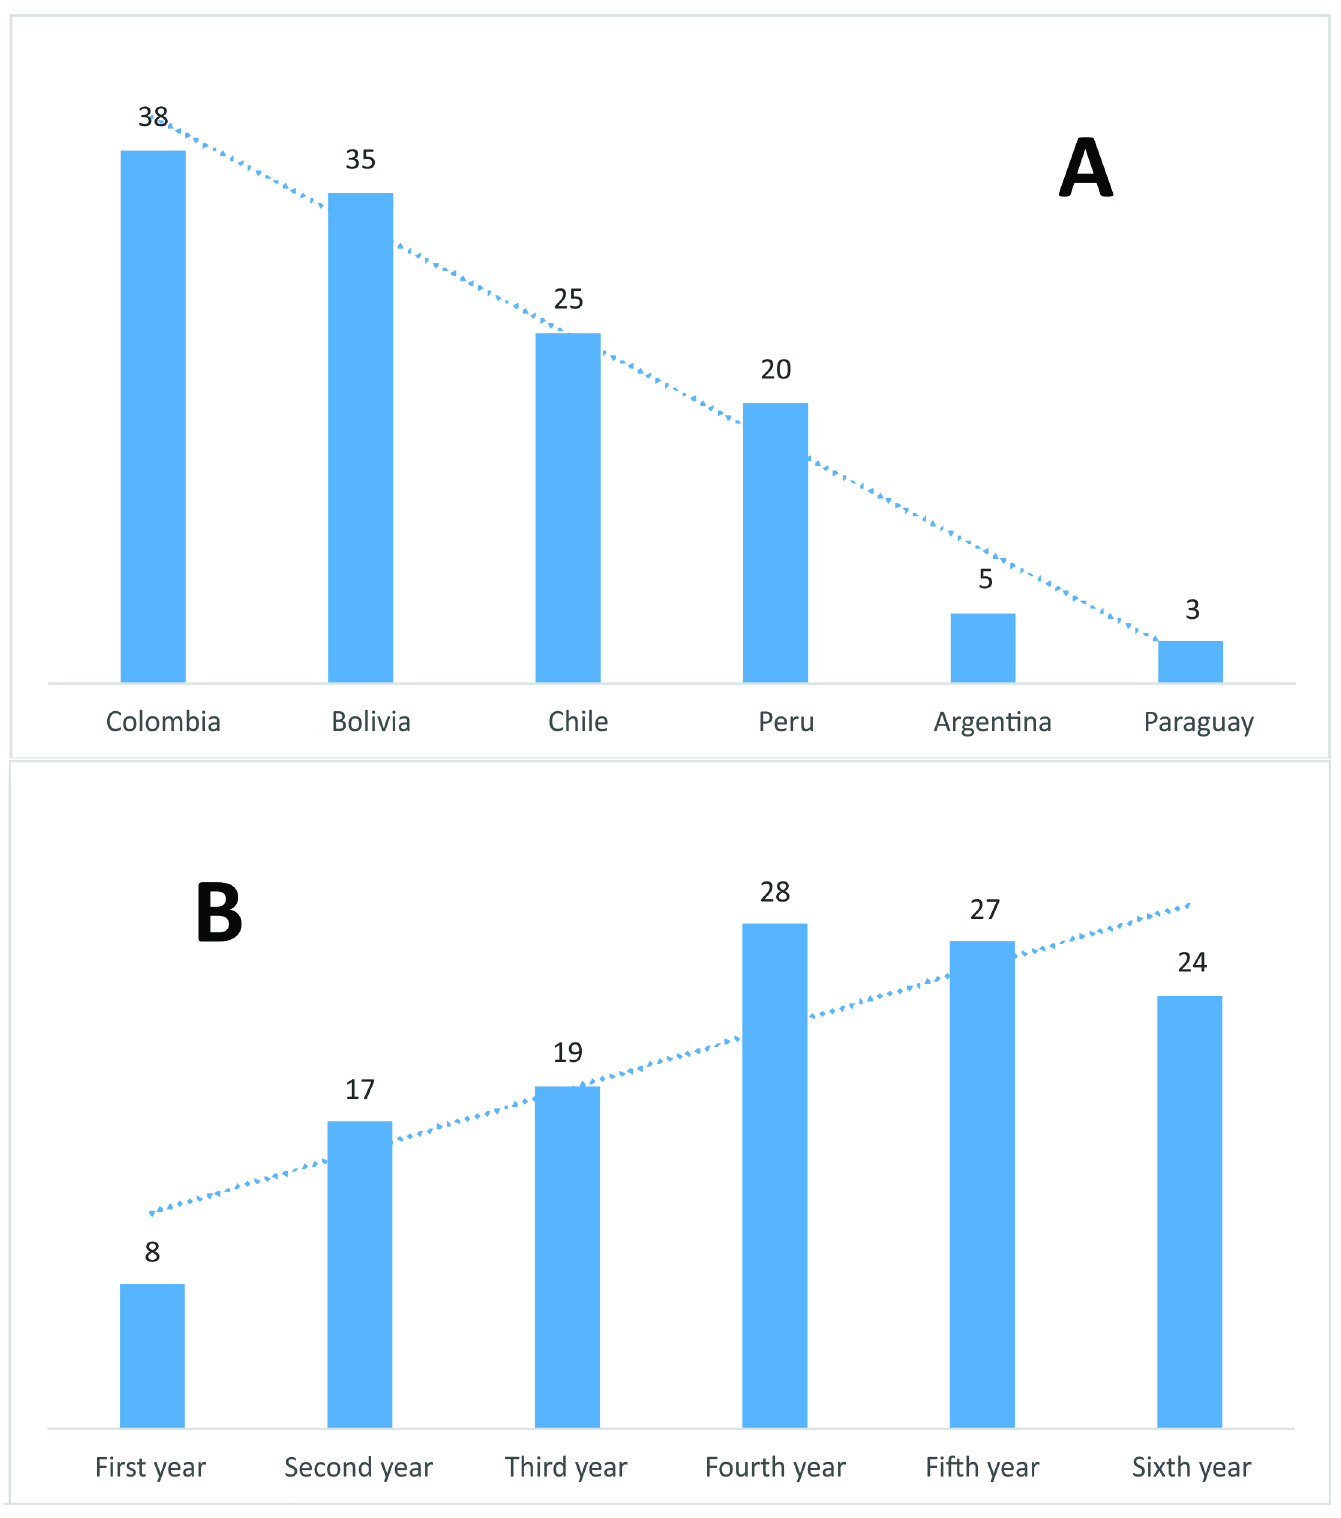
Fig 1. (A) Percentageof students with knowledgeof Sci-Hub by country and (B) by year of study.